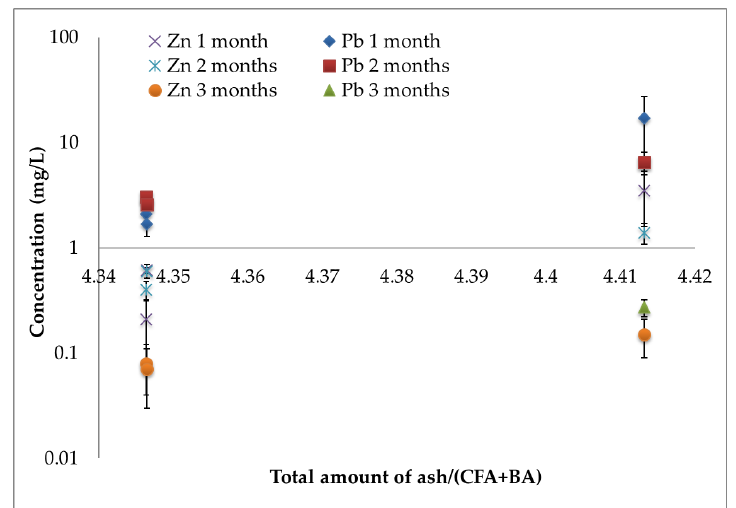
Figure 4. Concentration values of Pb and Zn in the leaching of stabilized samples (involving procedure a)) during the first three months versus the partition of total amount of ash and the sum of CFA and BA quantities.